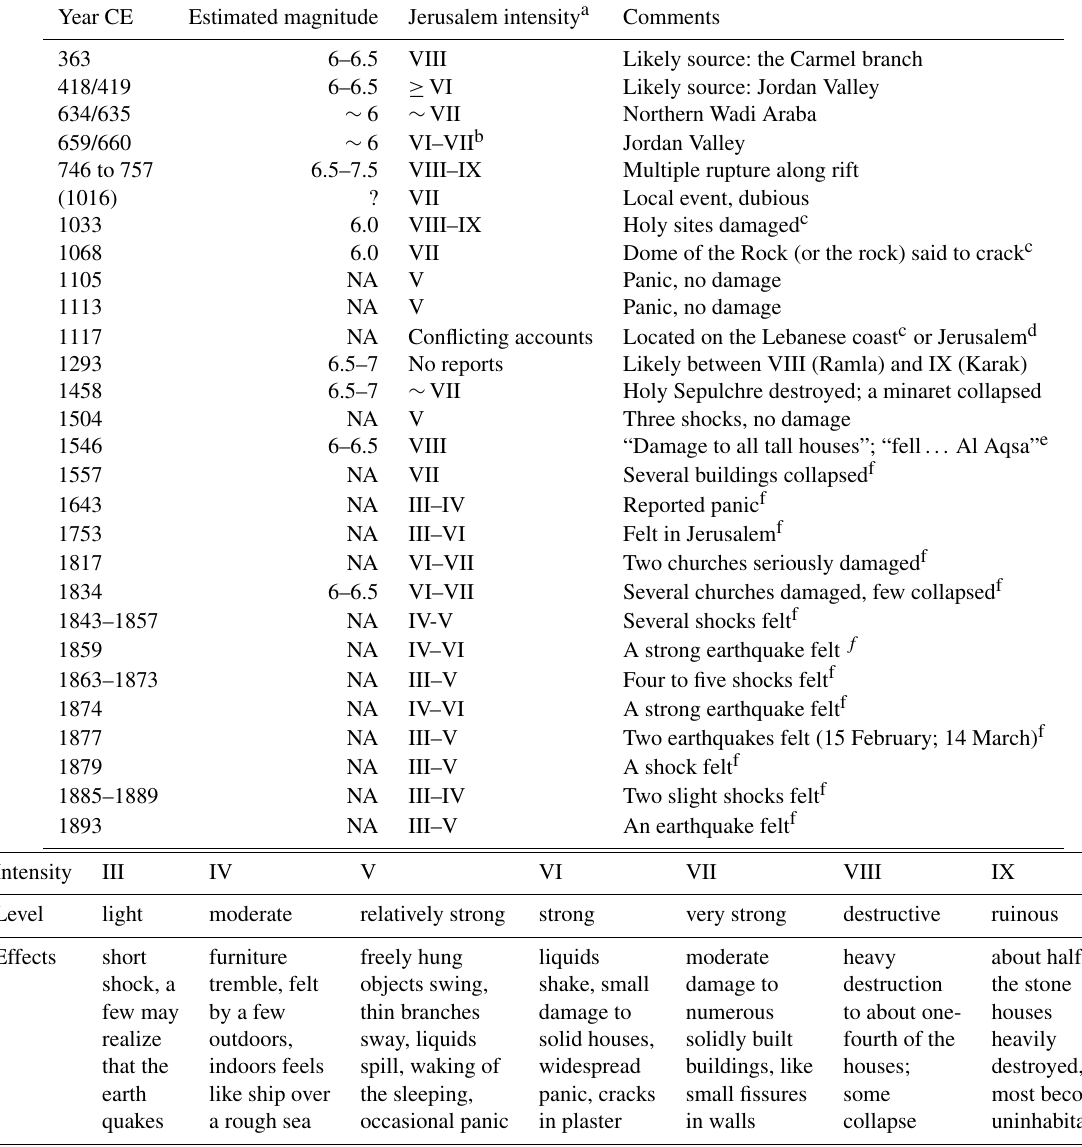
Table 1. Listing of historic (pre-instrumental) earthquakes that damaged Jerusalem since Roman times.